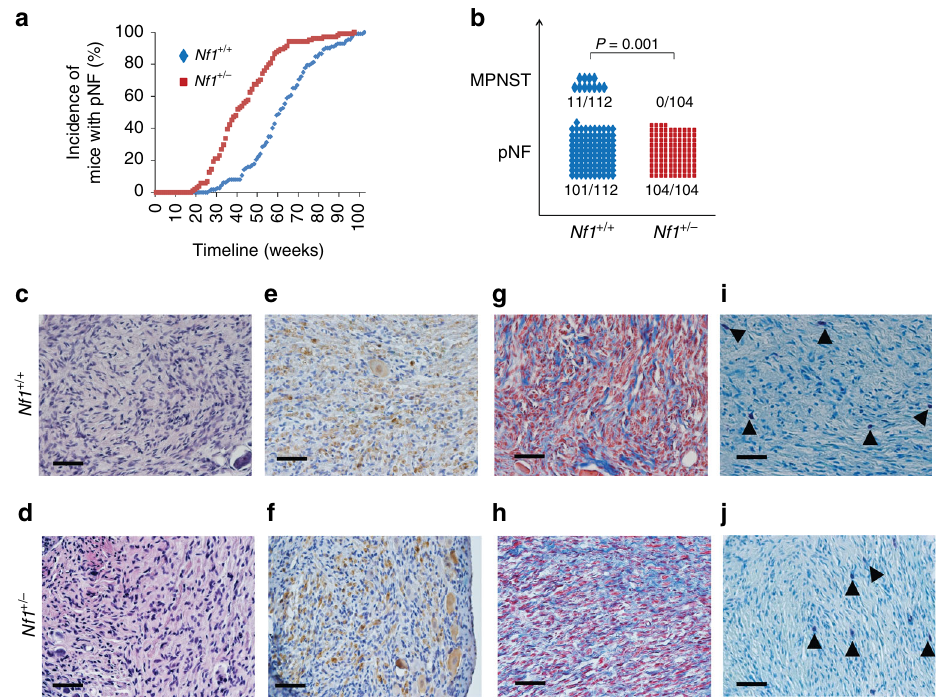
Fig. 5 Antagonistic role of Nf1 + / − microenvironment in plexiform neuro fi broma and MPNST formation. a Incidence of mice with plexiform neuro fi broma (pNF). b Tumor were classi fi ed as pNF (benign) or MPNST (malignant) based on histology. Fischer exact test statistic was performed. c – j Representative c , d H&E; e , f IHC using S100 g, h trichrome and i , j toluidine blue (arrow head pointing toward mast cells) staining in histological sections of dissected pNF from PLP CreERT2; Nf1 f/f ( c , e , g , i ) and PLP CreERT2; Nf1 f/ − ( d , f , h , j ). Scale bar is equal to 50 μ